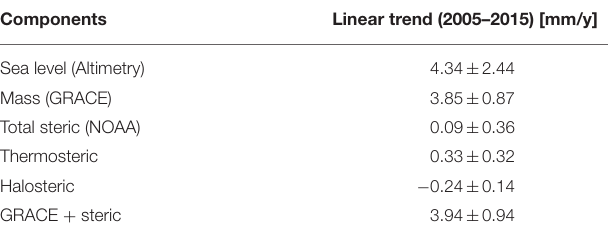
TABLE 1 | Linear trend of sea level trend budget elements.